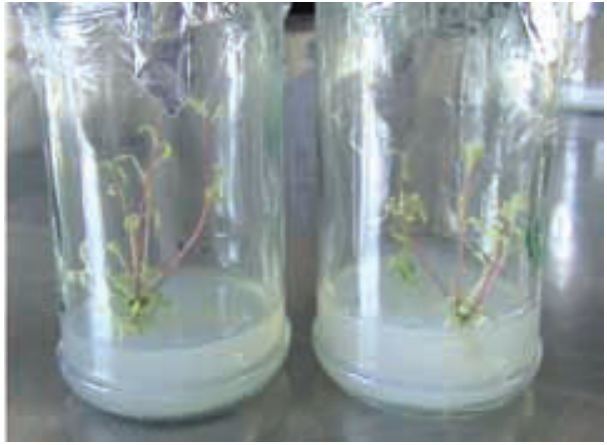
Fig. 3. In vitro elongation of Atriplex halimus L on control